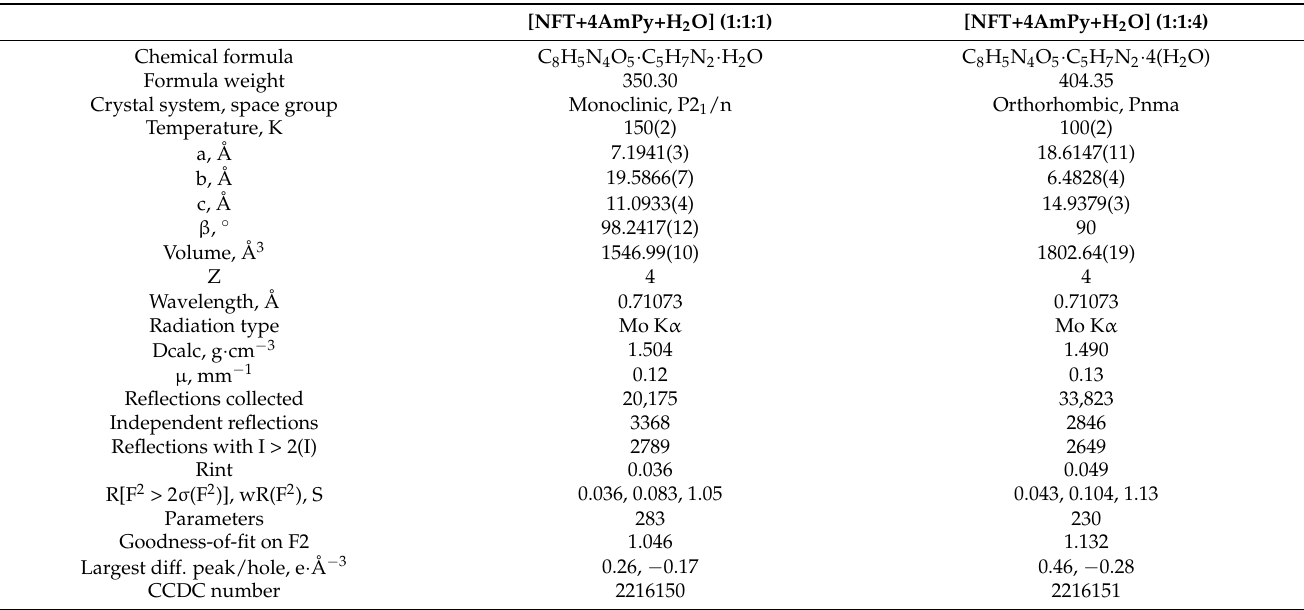
Table 2. Crystallographic data for the NFT hydrated